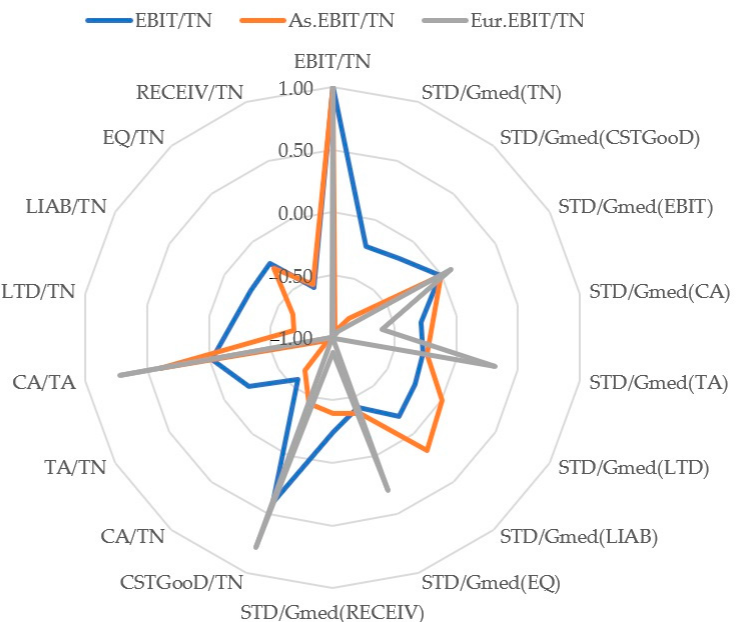
Figure 10. Pearson correlation plot of regressors against the dependent variable of financial efficiency segmented regionally and globally.